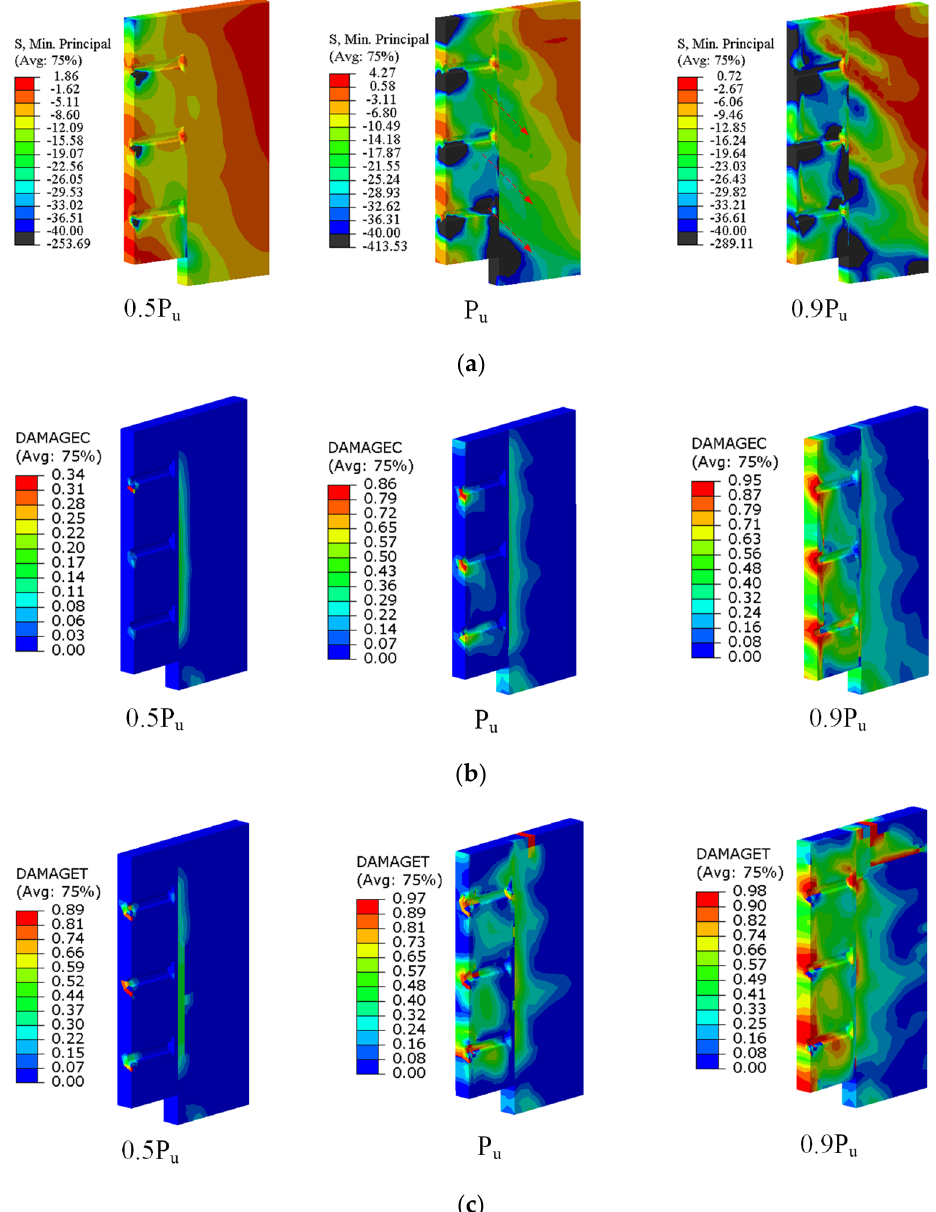
Figure 16. Damage evolution of concrete (precast concrete − UHPC): ( a ) Stress distribution; ( b ) Com- pressive damage; ( c ) Tensile damage.